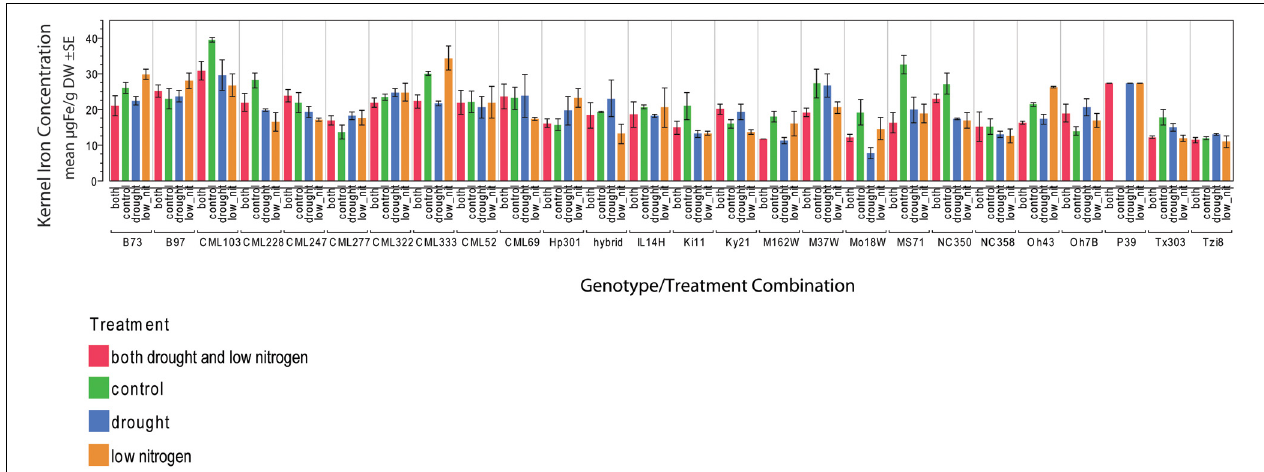
FIGURE 2 | Kernel iron concentrations by genotype-treatment combination. Iron concentration data are represented in μ g Fe g − 1 DW as an average of three technical